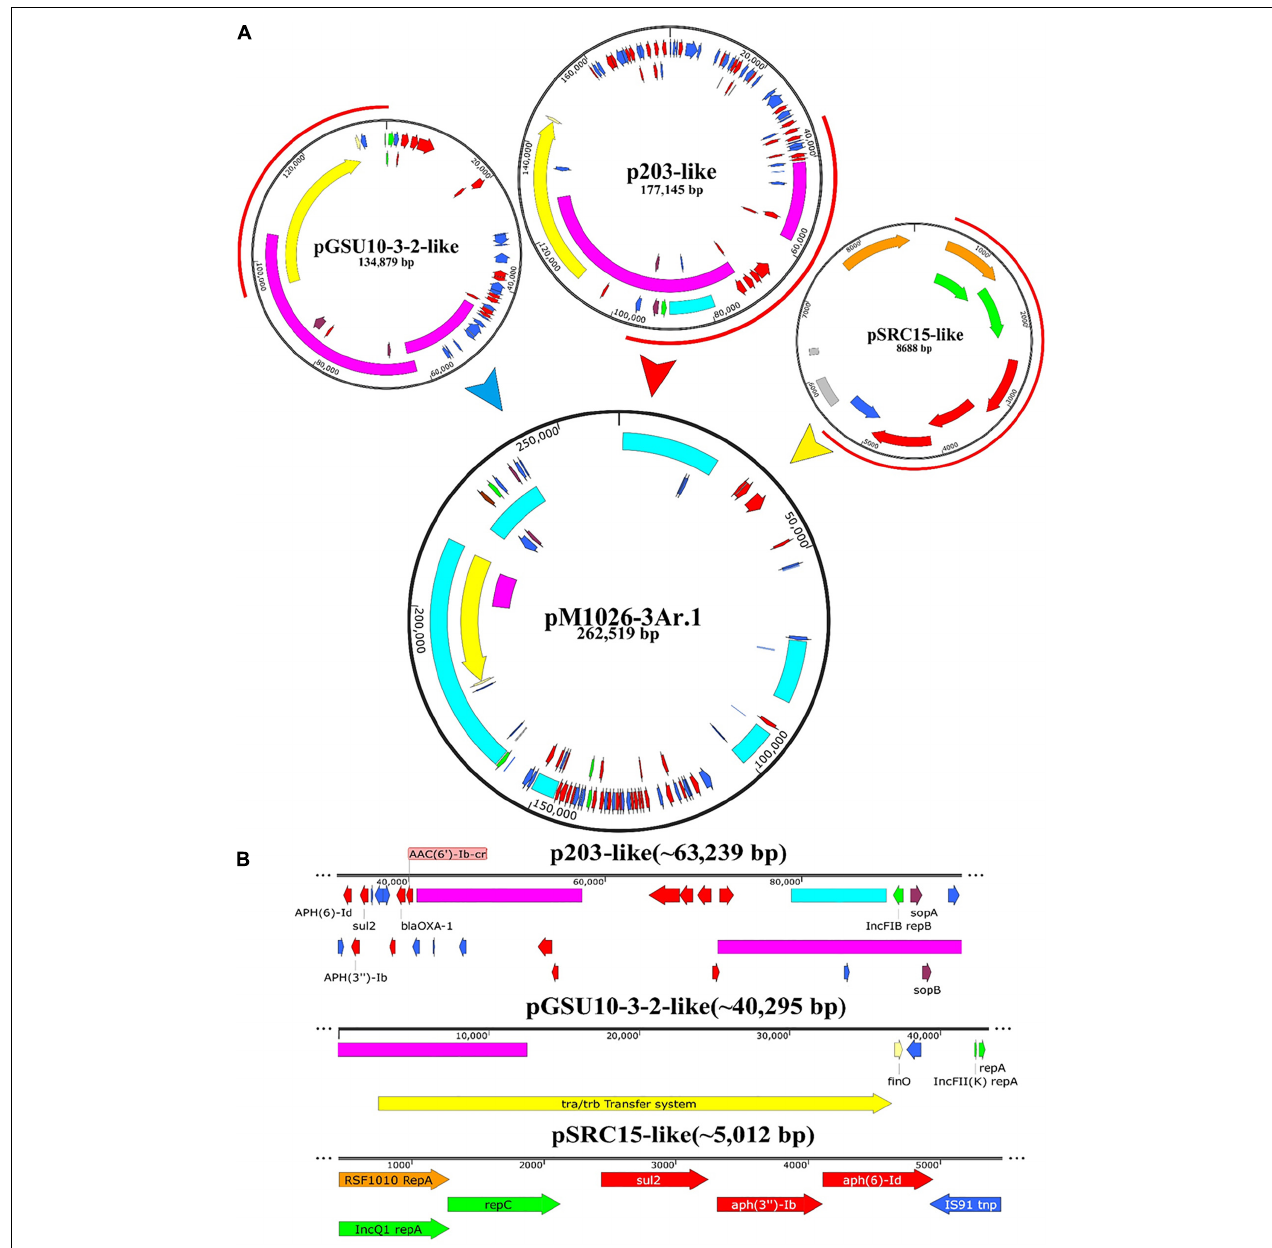
FIGURE 5 | Schematic diagram of the potential fusion process of plasmid pM1026-3Ar.1. (A) Fusion process of plasmids P203, pGSU10-3-2, and pSRC15. Red semicircle on the outside of the plasmid indicates the fusion region. (B) Specific structure and genetic composition of the fusion fragments provided by plasmids P203, pGSU10-3-2, and